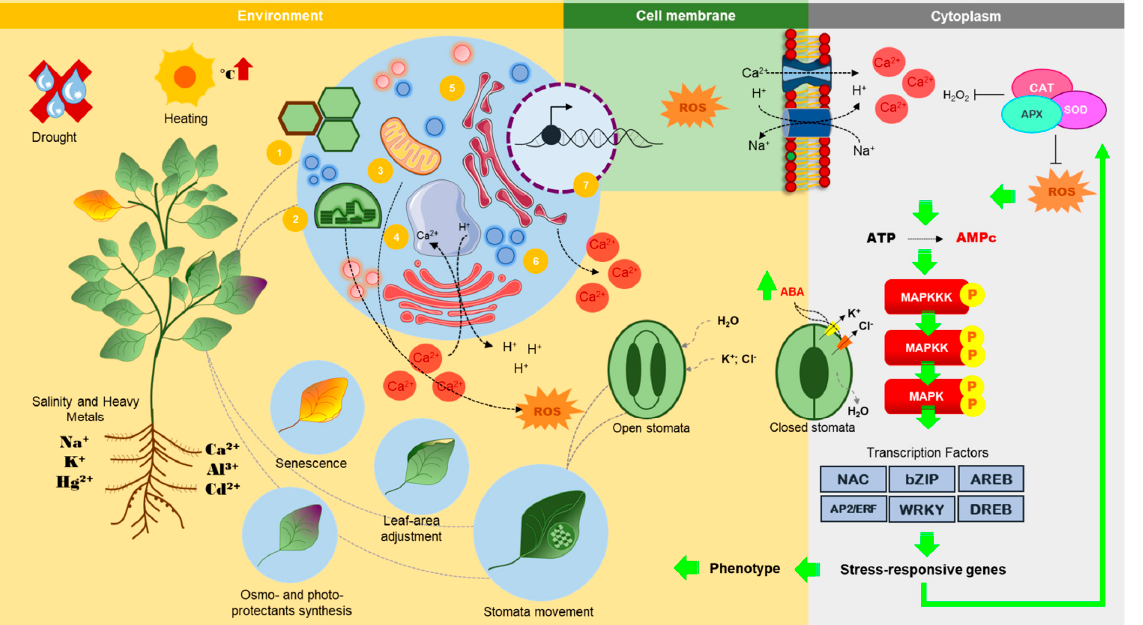
Figure 1. Abiotic stresses signal integration and adaptive responses in plants. Plants perceive dif- ferent stress signals through primary receptors, which may be embedded in their plasma